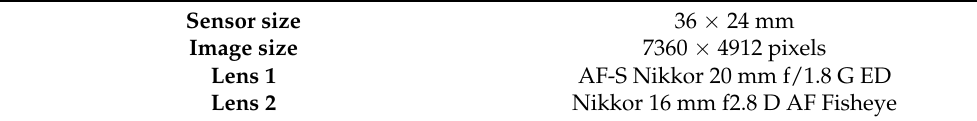
Table 2. Parameters of the Nikon D800E DSLR.